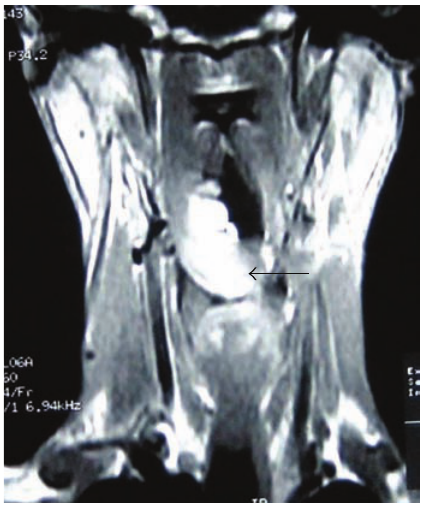
Figure 3: A T2-weighted MRI coronal image showing the hyperin- tense lesion.